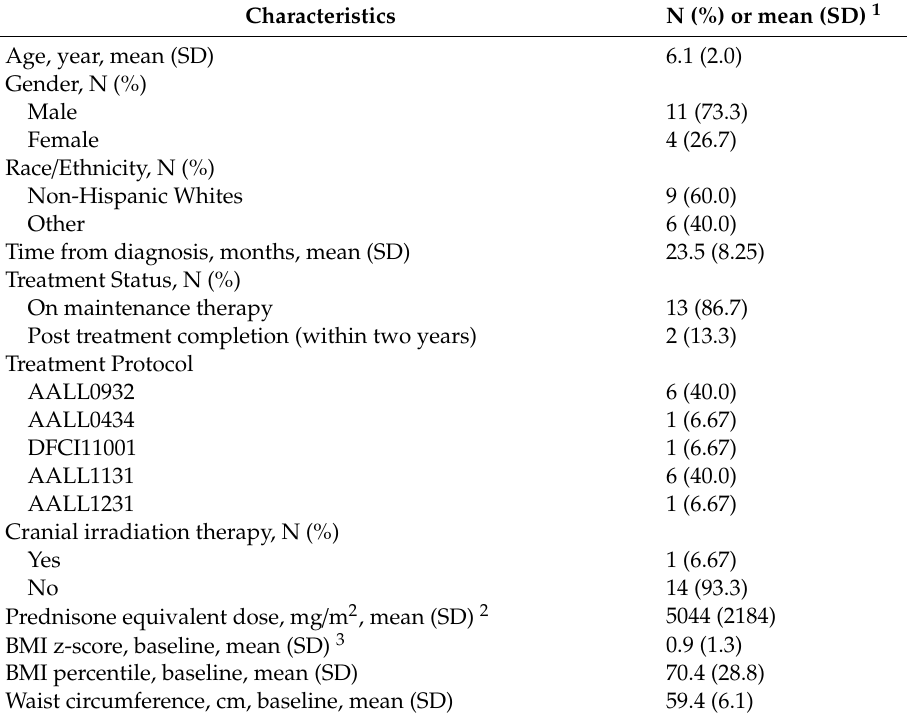
Table 1. Characteristics of pediatric patients with acute lymphoblastic leukemia (ALL) enrolled in the Healthy Eating and Active Living (HEAL) pilot